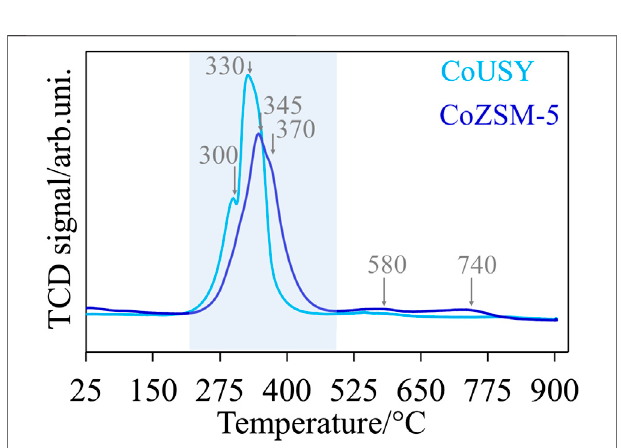
FIGURE 7 | H 2 -TPR pro fi les of the CoUSY and CoZSM-5 catalysts.